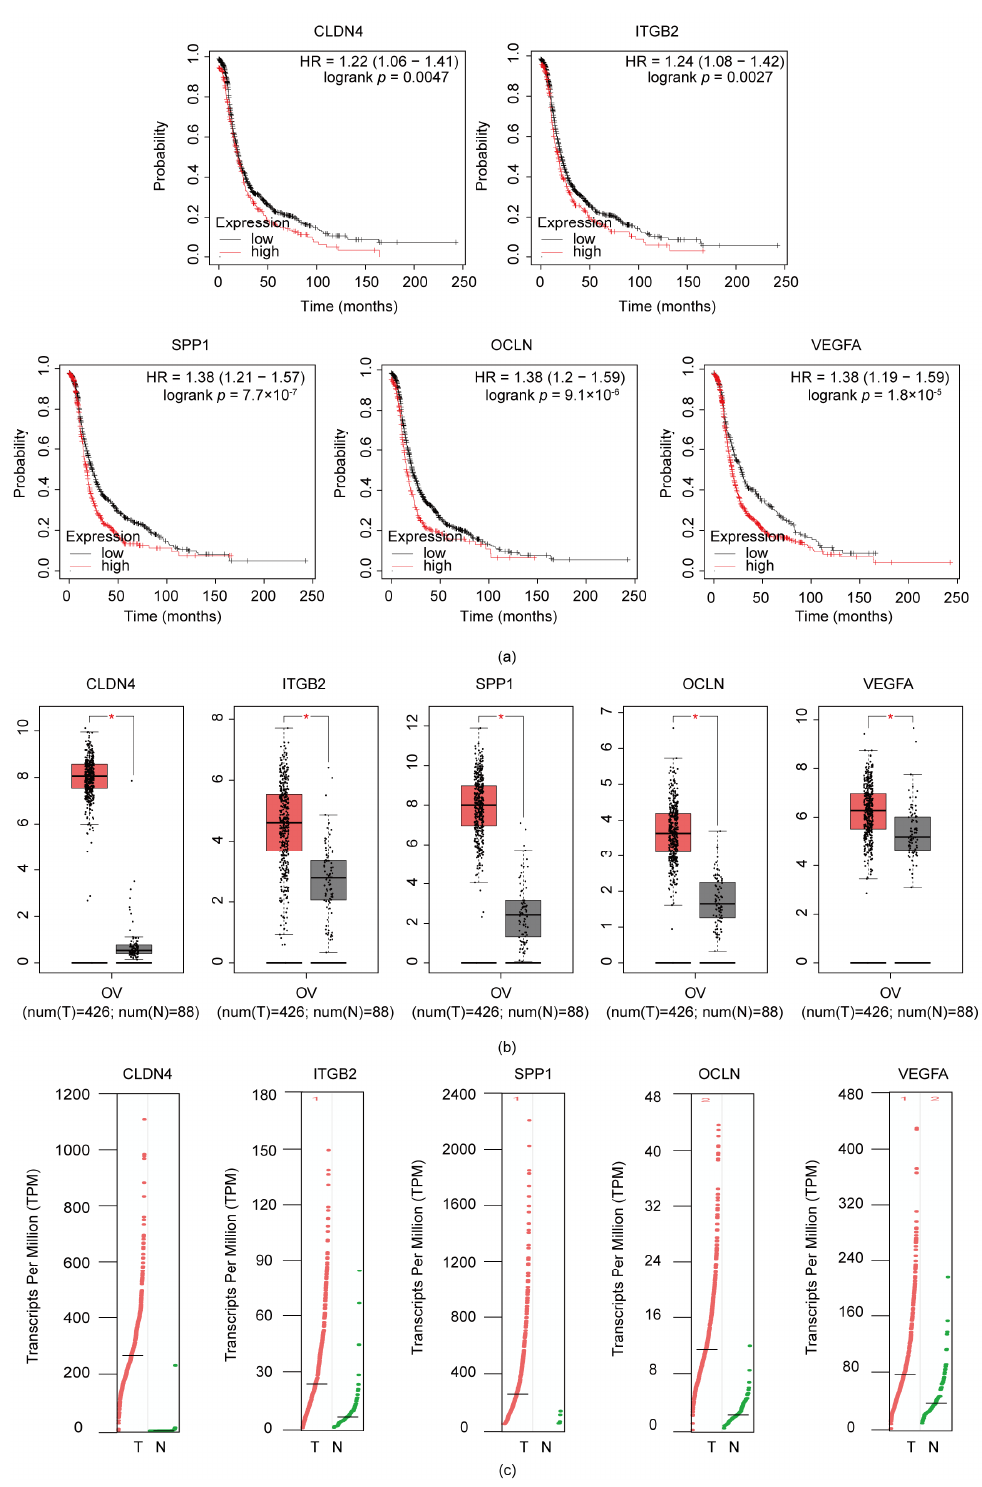
Figure 3. Potential expression of prognostic hub genes in ovarian cancer. ( a ) ITGB2, VEGFA, CLDN4, OCLN, and SPP1 were correlated with unfavorable progression free survival for serous ovarian cancer patients; ( b , c ) Expression of ITGB2, VEGFA, CLDN4, OCLN, and SPP1 in serous ovarian cancers, compared with non-ovarian tumor tissues (* p <